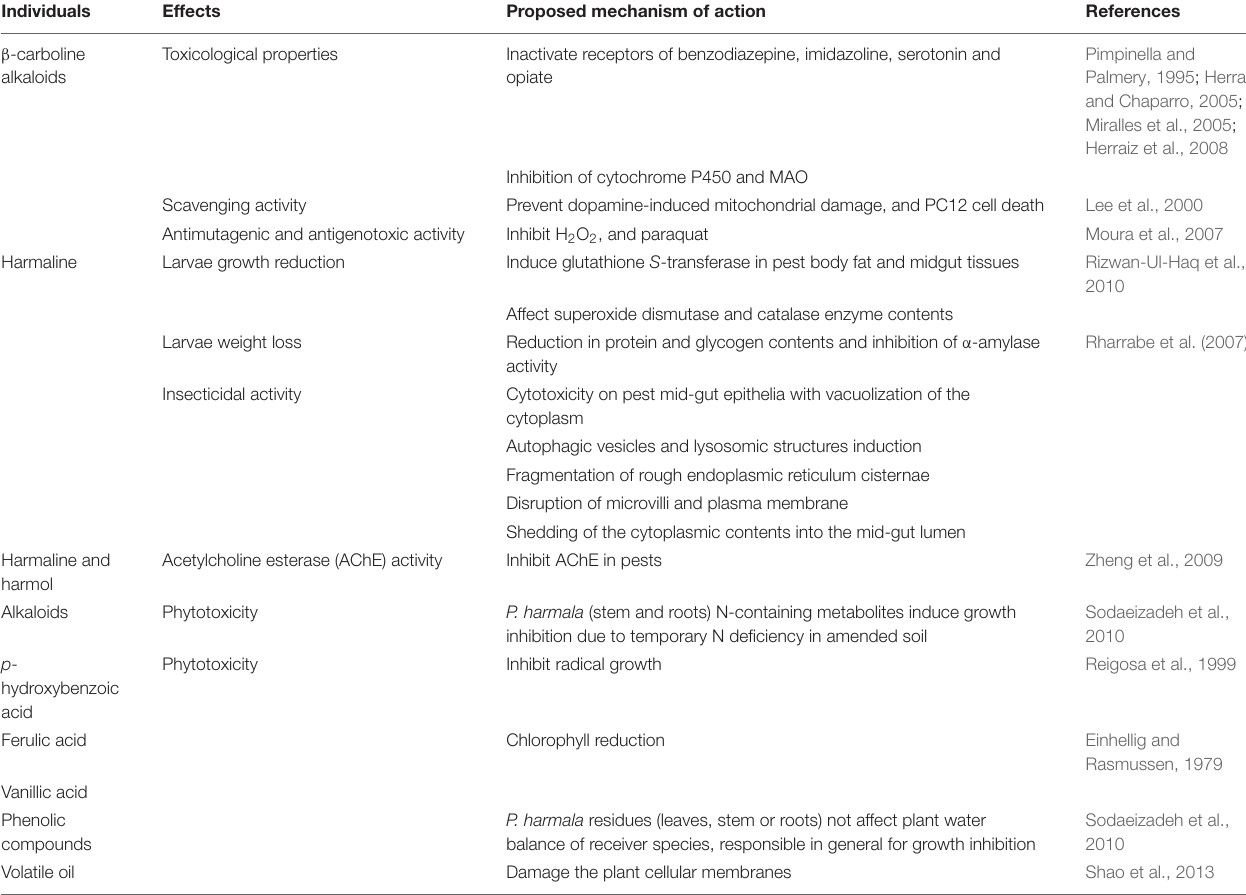
TABLE 2 | Available mechanisms of action of Peganum individuals toward insects and